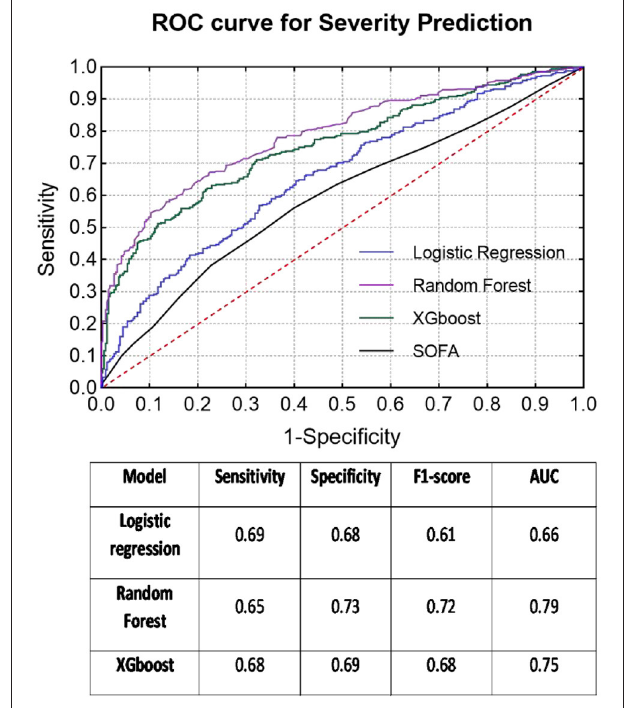
FIGURE 1 | ROC curves of each classifier with SMOTE for mortality prediction. Classification results before and after SMOTE are presented in the embedded table.